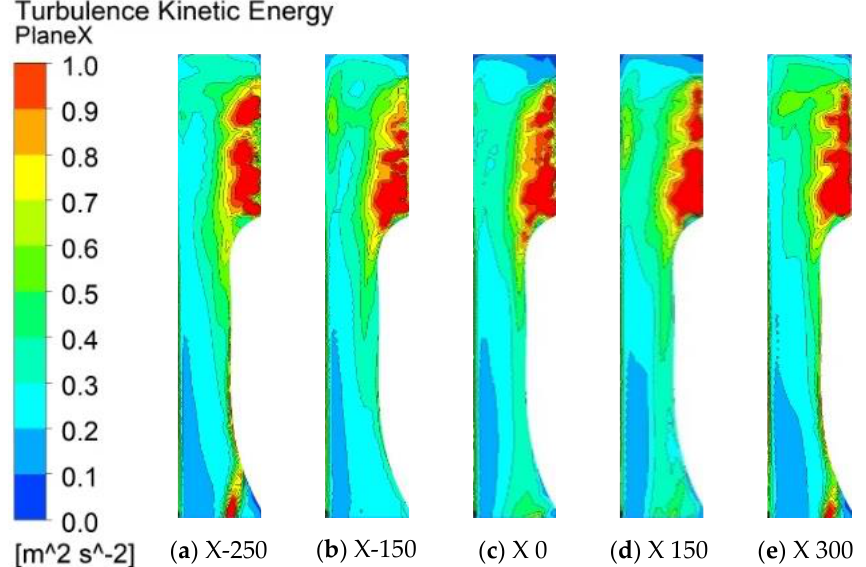
Figure 20. Turbulent energy clouds for different X-directional cross-sections in the optimized head duct of the integrated stove.